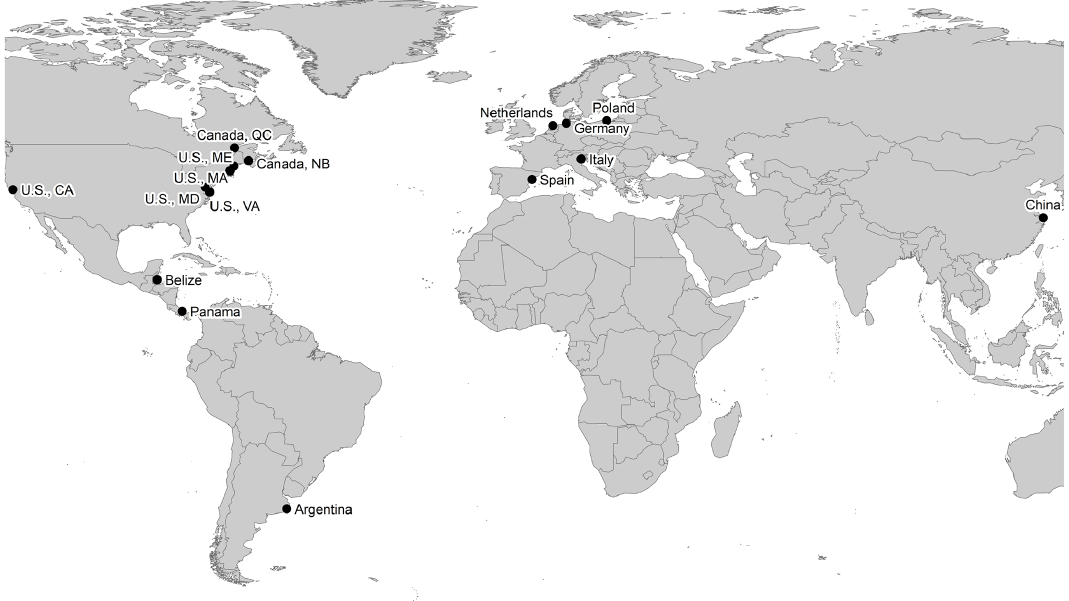
Figure 1. Overview map of study regions. Notes: see Table 1 for region and site